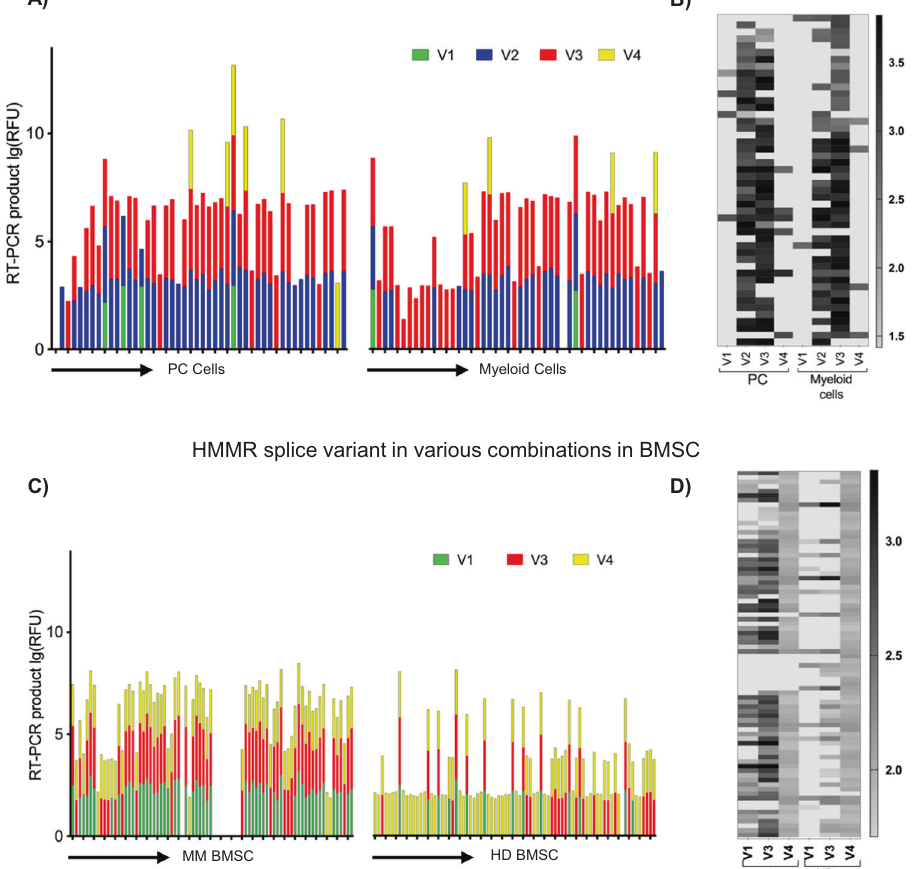
Fig. 2 HMMR splice variant transcripts are frequently and recurrently expressed in different subpopulation of cells from MM patients. This fi gure displays HMMR splice variant expressions at a single-cell level. MM or HD cells were sorted by index sorting followed by RT-PCR DNA fragment analyses and capillary electrophoresis. A , B display HMMR splice variant expression at the single-cell level in MM-PCs and myeloid cells, while C and D display the expression of those variants in autologous MM BMSCs and HD BMSCs. A , C show HMMR splice variant co-expression levels. In these fi gures, the x axes display cells and the y axes relative fl uorescent units (RFU) of the PCR products. PCR product RFU = lg(RFU). RFU is a unit of measurement calculated relative to the size standards included in each reaction. B , D The overall distribution of the HMMR splice variants in different subpopulations of MM and HD samples are presented as heatmaps. The color scale for expression values is shown on the